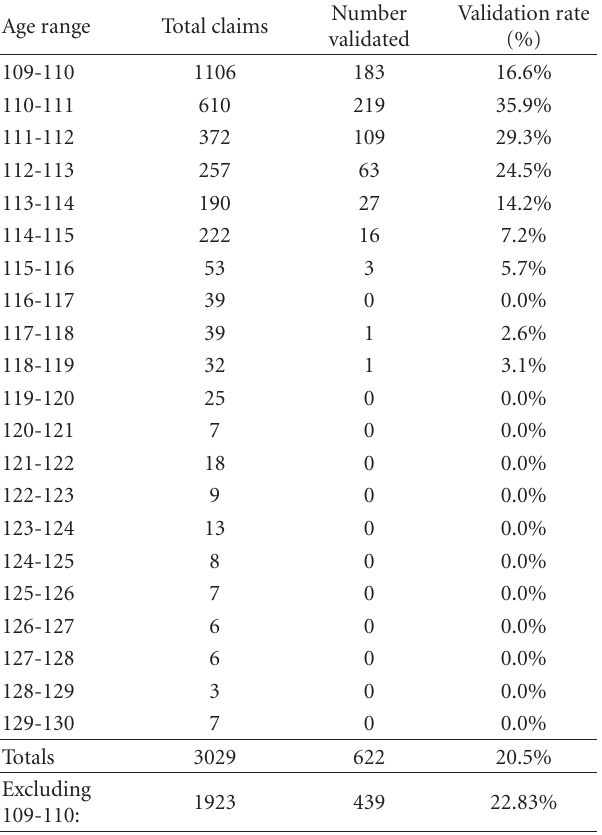
Table 1: Social Security Death Index-generated frequencies of alleged supercentenarians whose deaths were reported between 1980 and 2009 and validation